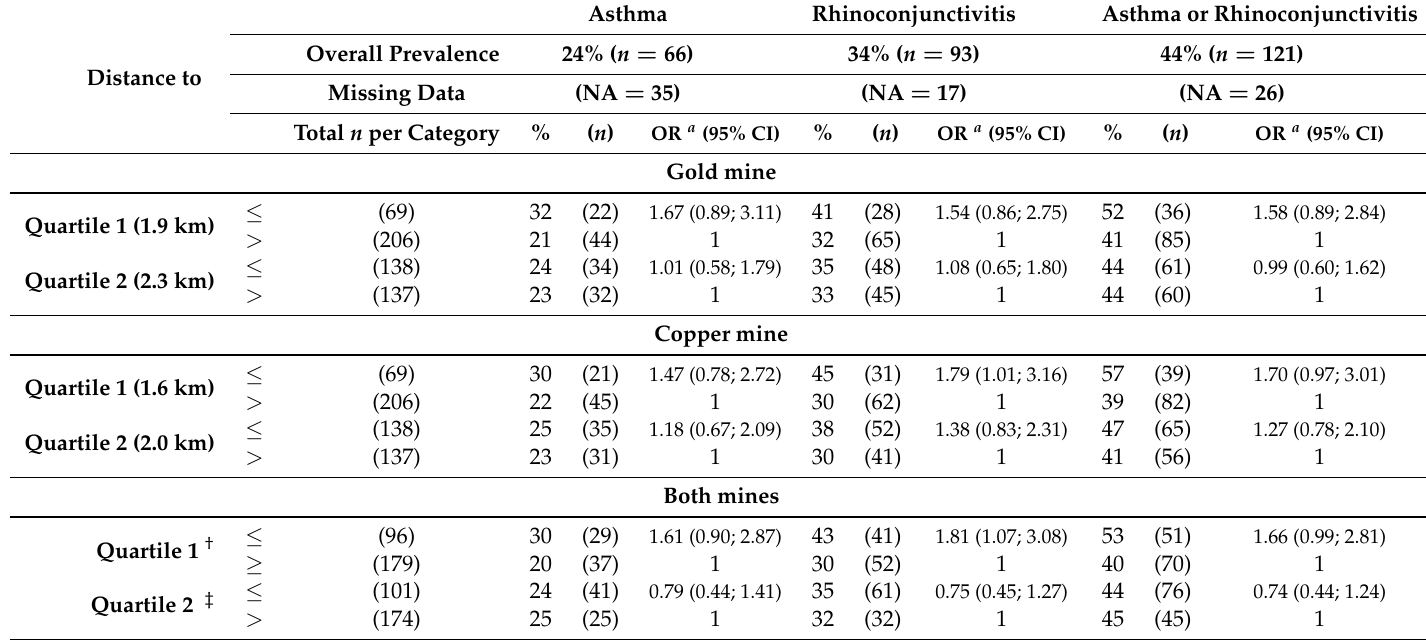
† Indicates distances above the first quartile to either mine; ‡ indicates distances above the second quartile to either mine; NA: missing values; a unadjusted odds ratios using logistic